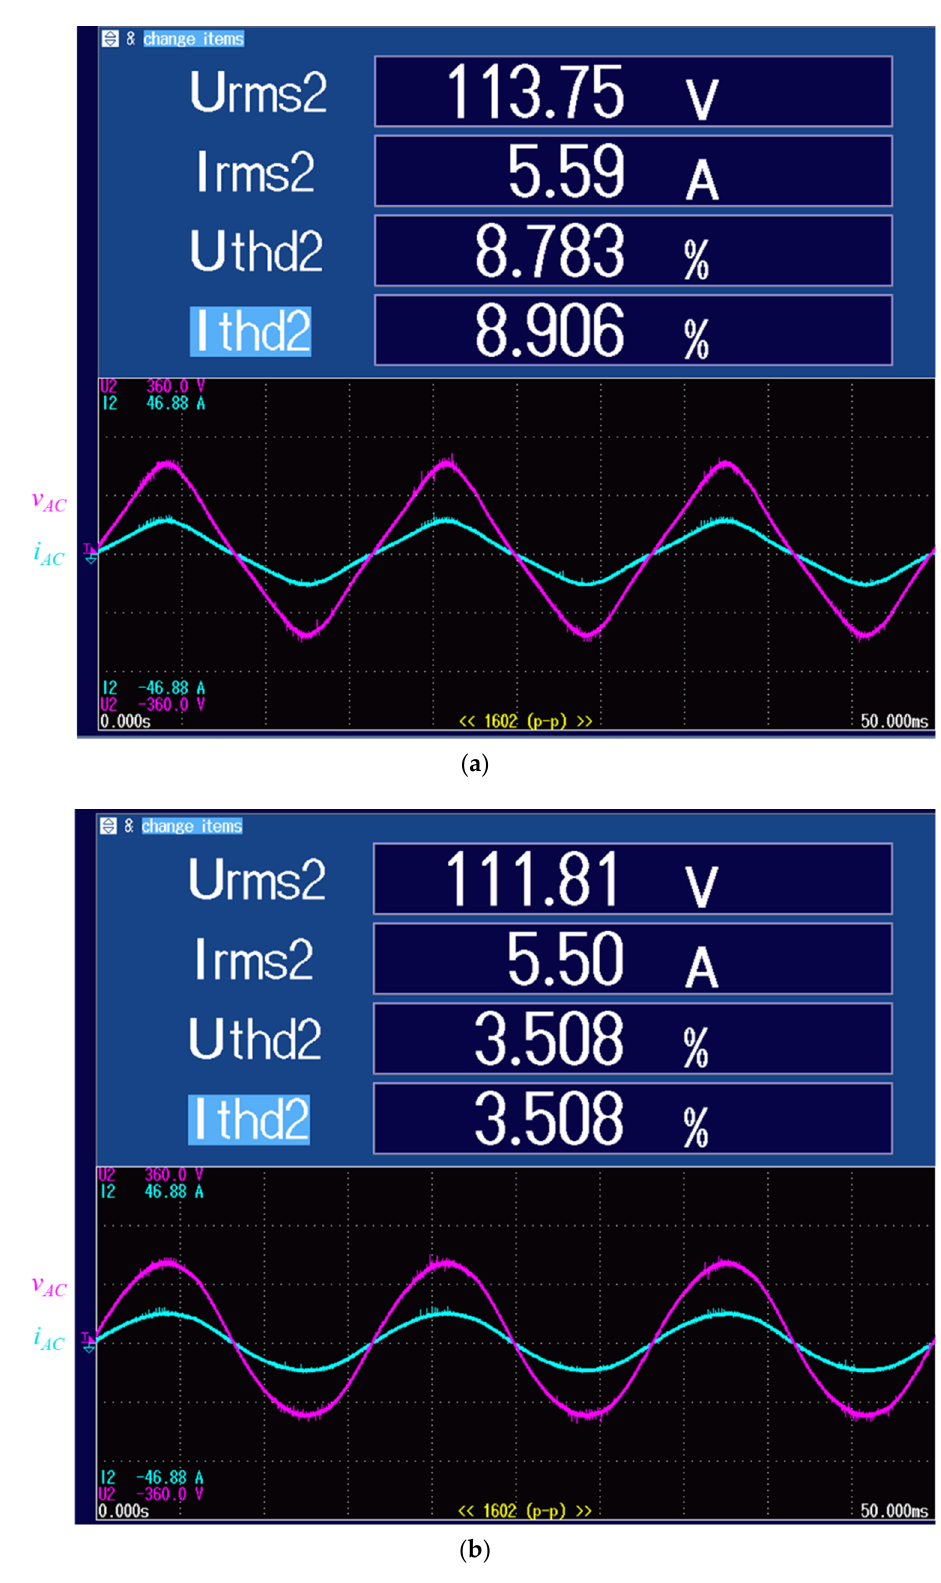
Figure 25. THD analysis in hardware experiments (500 W) when using ( a ) the traditional SPWM control and ( b ) modified SPWM control.